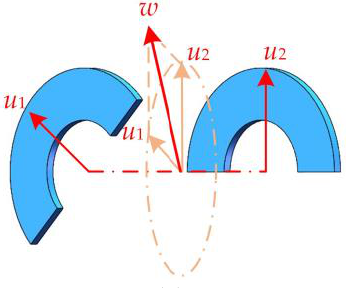
Figure 11. Schematic diagram of eccentric mass. ( a ) Adding weight; ( b ) reducing weight.